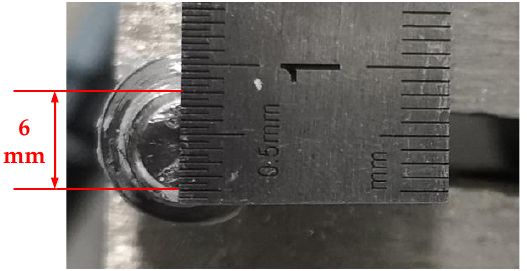
Figure 2. Sensor measuring end diameter.